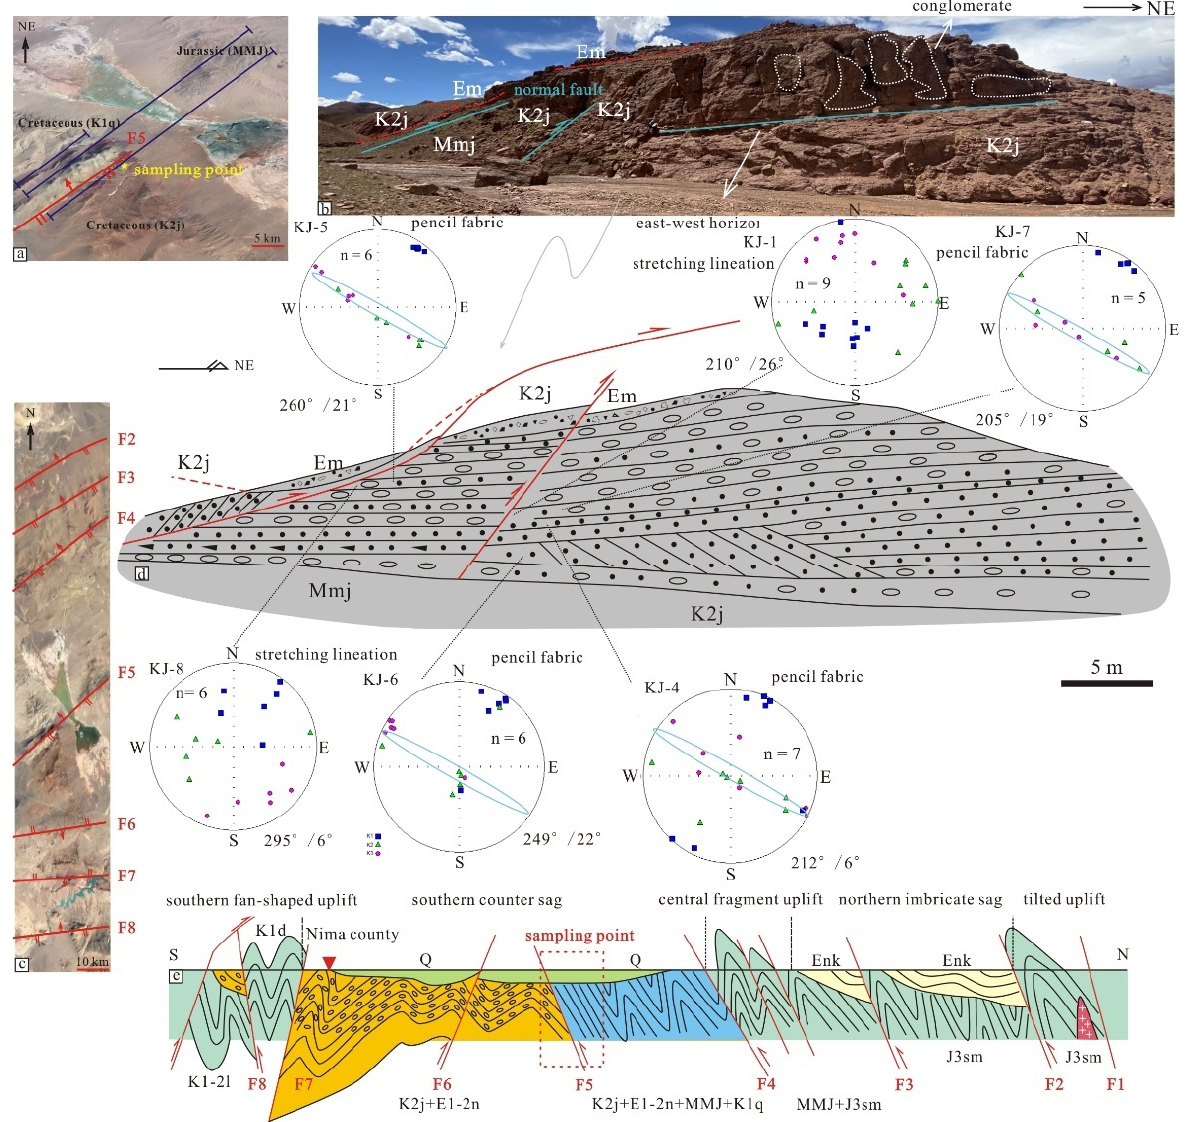
Figure 12. Magnetic fabric characteristics of thrust structures in the Nyima Basin. ( a ) trend of thrust fracture where the strain fabric is located; ( b ) the fracture section where the strain fabric is located; ( c ) distribution of main faults in Nyima Basin; ( d ) the relationship between lithology, formation contact and strain fabric of the fault section where the strain fabric is located; ( e ) the north-south transverse section of the main fault in the Nyima Basin.